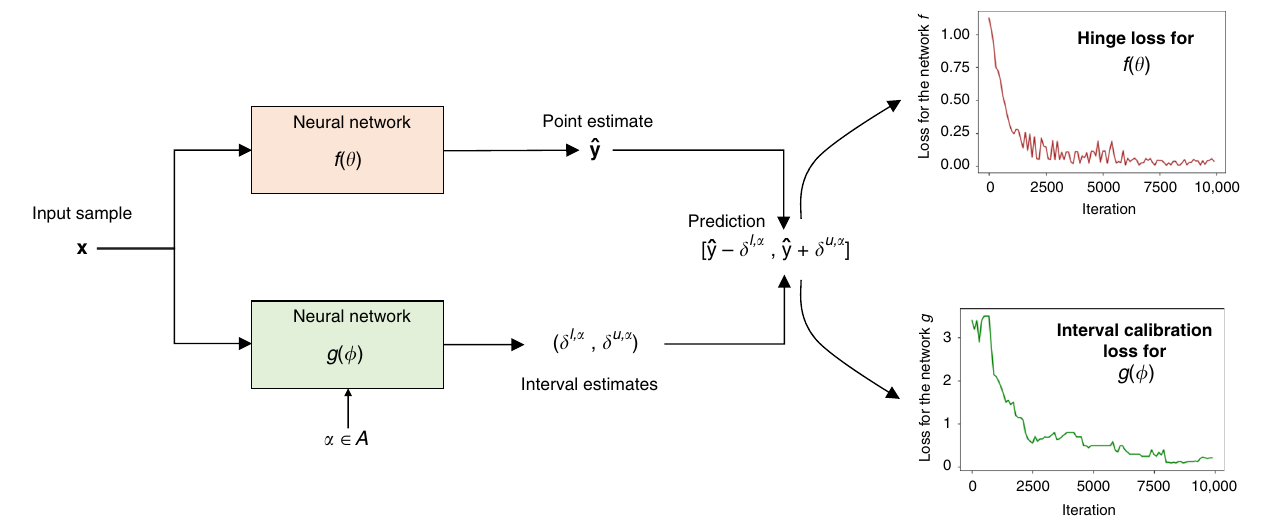
Fig. 5 Learn-by-Calibrating (LbC) architecture overview. LbC uses are two separate networks to obtain point estimates and the intervals, respectively. As shown by the convergence plots during training, the two models synergistically optimize for the overall objective of improving the interval